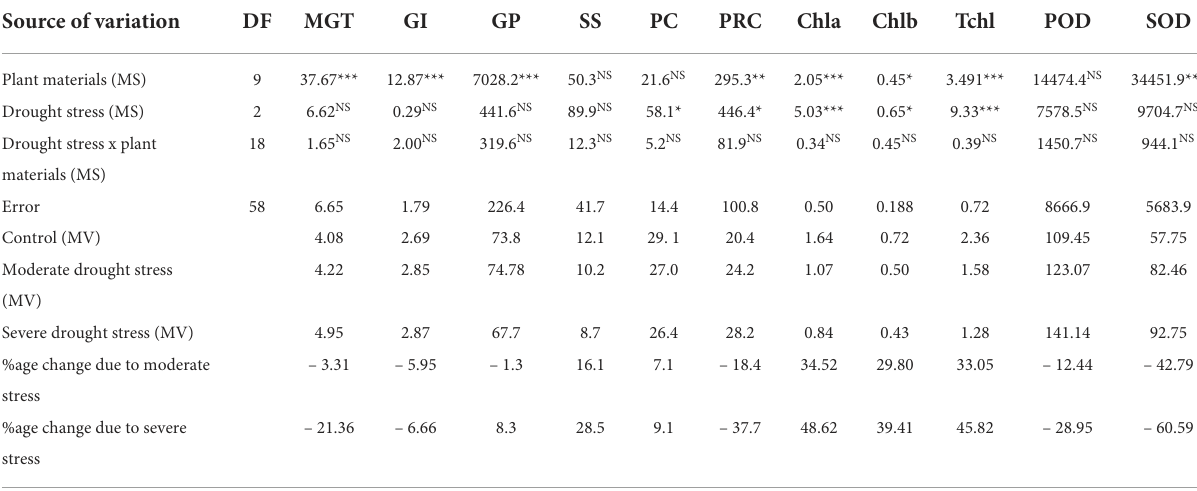
TABLE 2 Analysis of variance (mean squares), mean values, and percentage change in biochemical and physiological traits in the studied Elymus species and wheat cultivars. Source of variation DF MGT GI GP SS PC PRC Chla Chlb Tchl POD